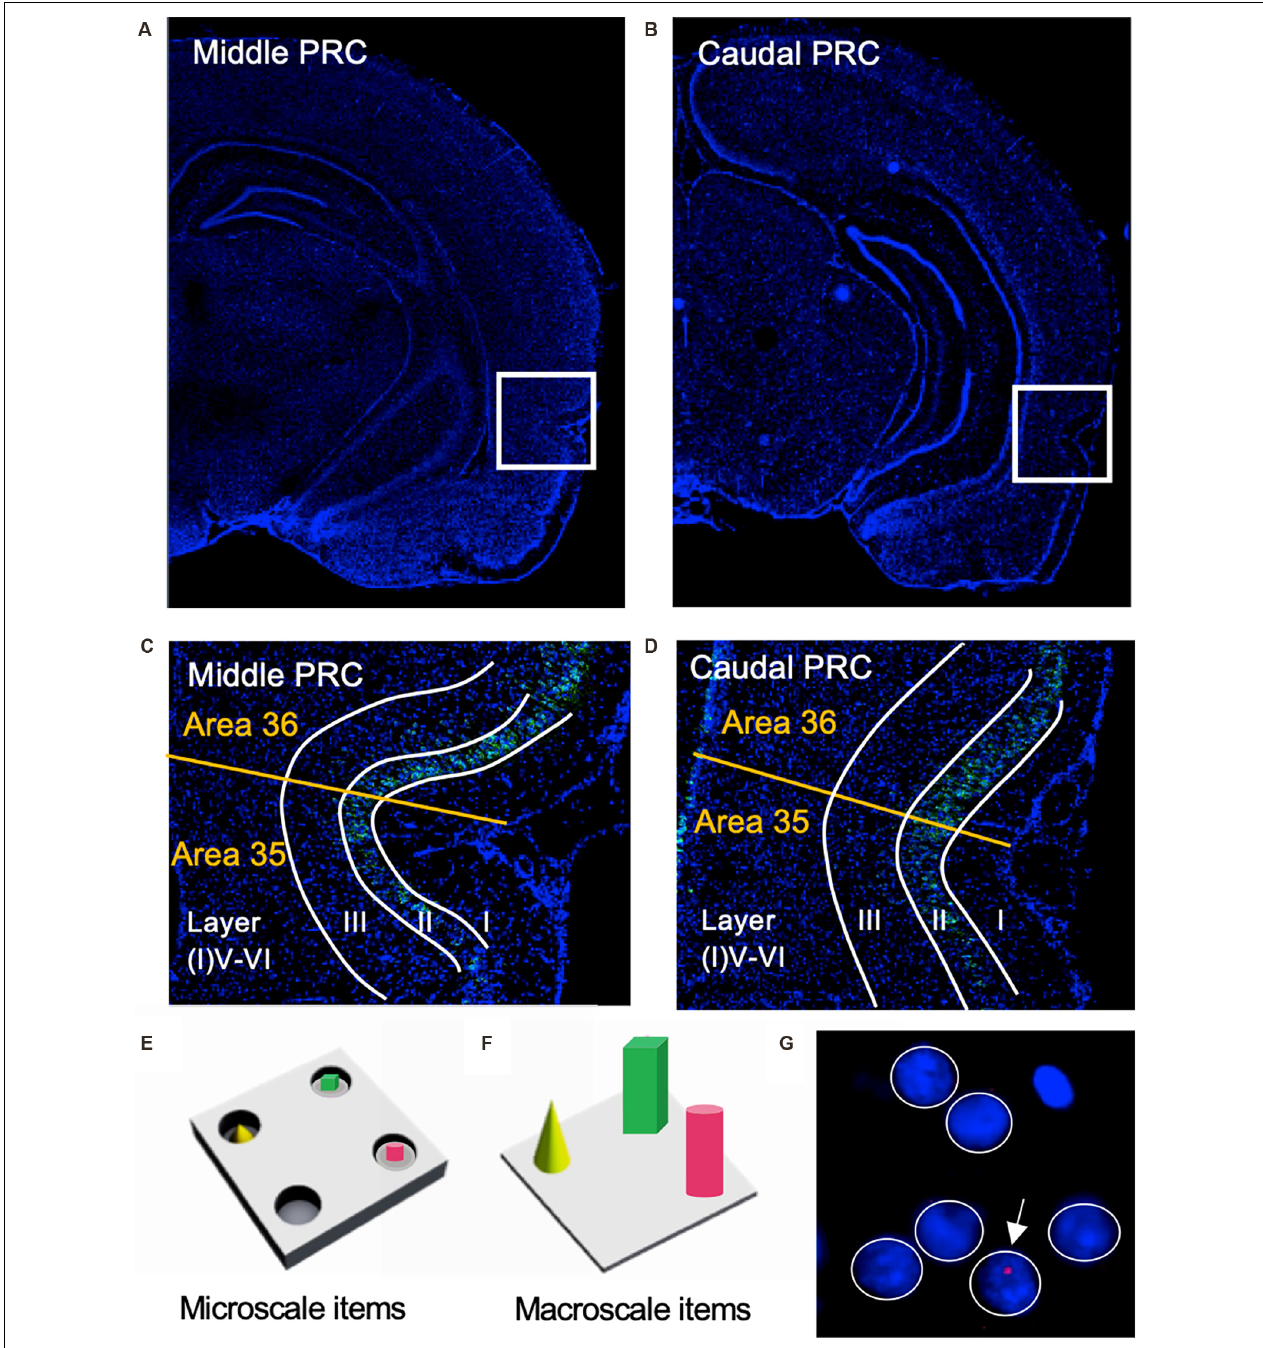
FIGURE 1 | Representation of perirhinal cortex areas and micro- and macroscale item paradigms. (A,B) DAPI (4 (cid:48) ,6-diamidino-2-phenylindole) stained (blue), nuclei in coronal sections of the rat brain, including outlines highlighting the middle (A) and caudal (B) compartments of the perirhinal cortex (PRC; indicated by white squares). (C,D) Layer organization of the PRC (indicated by white lines). Images were obtained and analyzed in layer II, III, and V-VI/IV-VI of areas 35 and 36 (separated by a yellow line) of the middle (C) and caudal (D) PRC. To simplify the differentiation of the superficial layers, WFS1 (Wolframin, green) was visualized in some sections of the middle and caudal PRC. Nuclei were stained with DAPI (blue). (E,F) Schema of microscale and macroscale item paradigm. Animals participated in a 5 min exploration task, in which small novel objects (microscale items) were placed within three of four holes of a hole board (E) , or three large novel objects (macroscale items) were placed on the floor of the chamber (F) . (G) Example of manual cell counting to identify somatic Arc mRNA FISH expression in the PRC. Nuclei were identified in an experimenter-blind manner and outlined (white circles). Red signals correspond to Arc mRNA expression. Nuclei that contained an Arc mRNA signal within the DAPI stained area were registered as positively labeled nuclei (indicated by white arrow). Nuclei of glial cells, which are characteristically small and strongly stained with DAPI, were excluded from analysis (top, right).